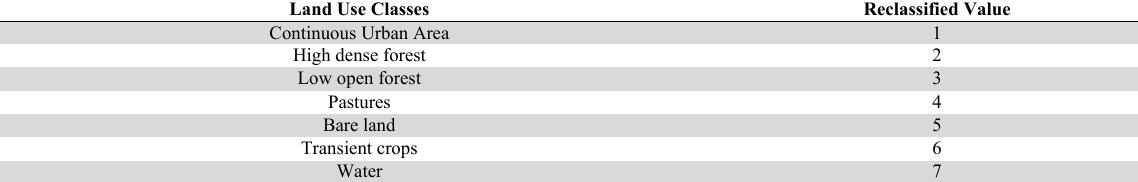
Land Use Classes Reclassified Value Continuous Urban